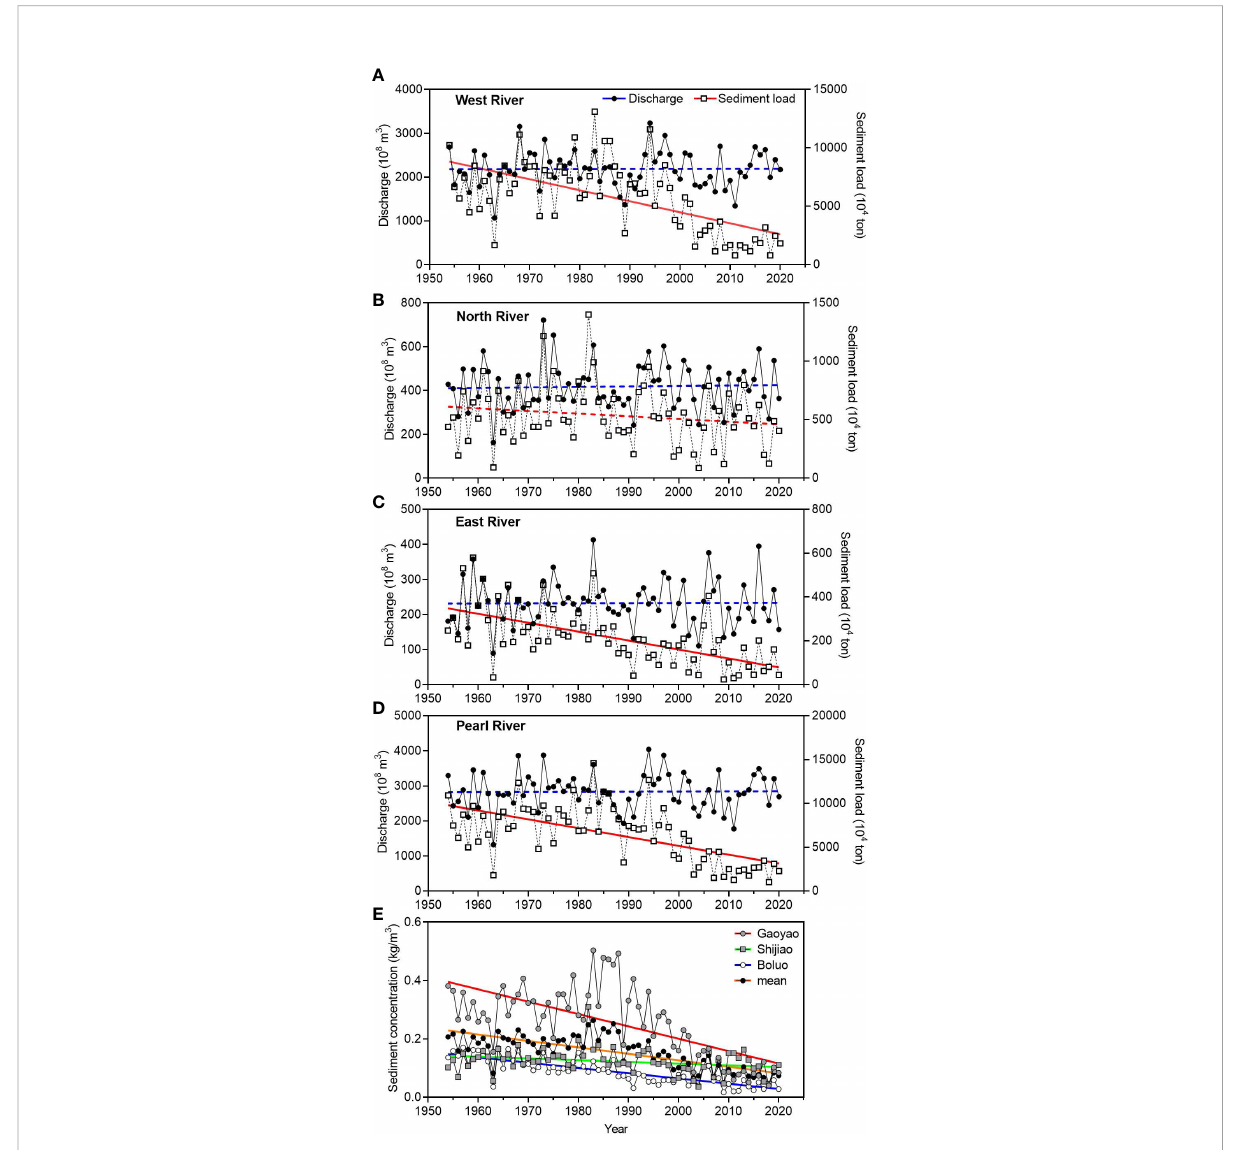
FIGURE 3 Temporal changes in annual discharge (a-d), sediment load (A-D) and suspended sediment concentration (E) in the Pearl River (D) as well as in its major tributaries, the West River (A) , North River (B) and East River (C) since 1954. Solid lines denote signi fi cant correlations ( P < 0.05), whereas dotted lines denote non-signi fi cant correlations.